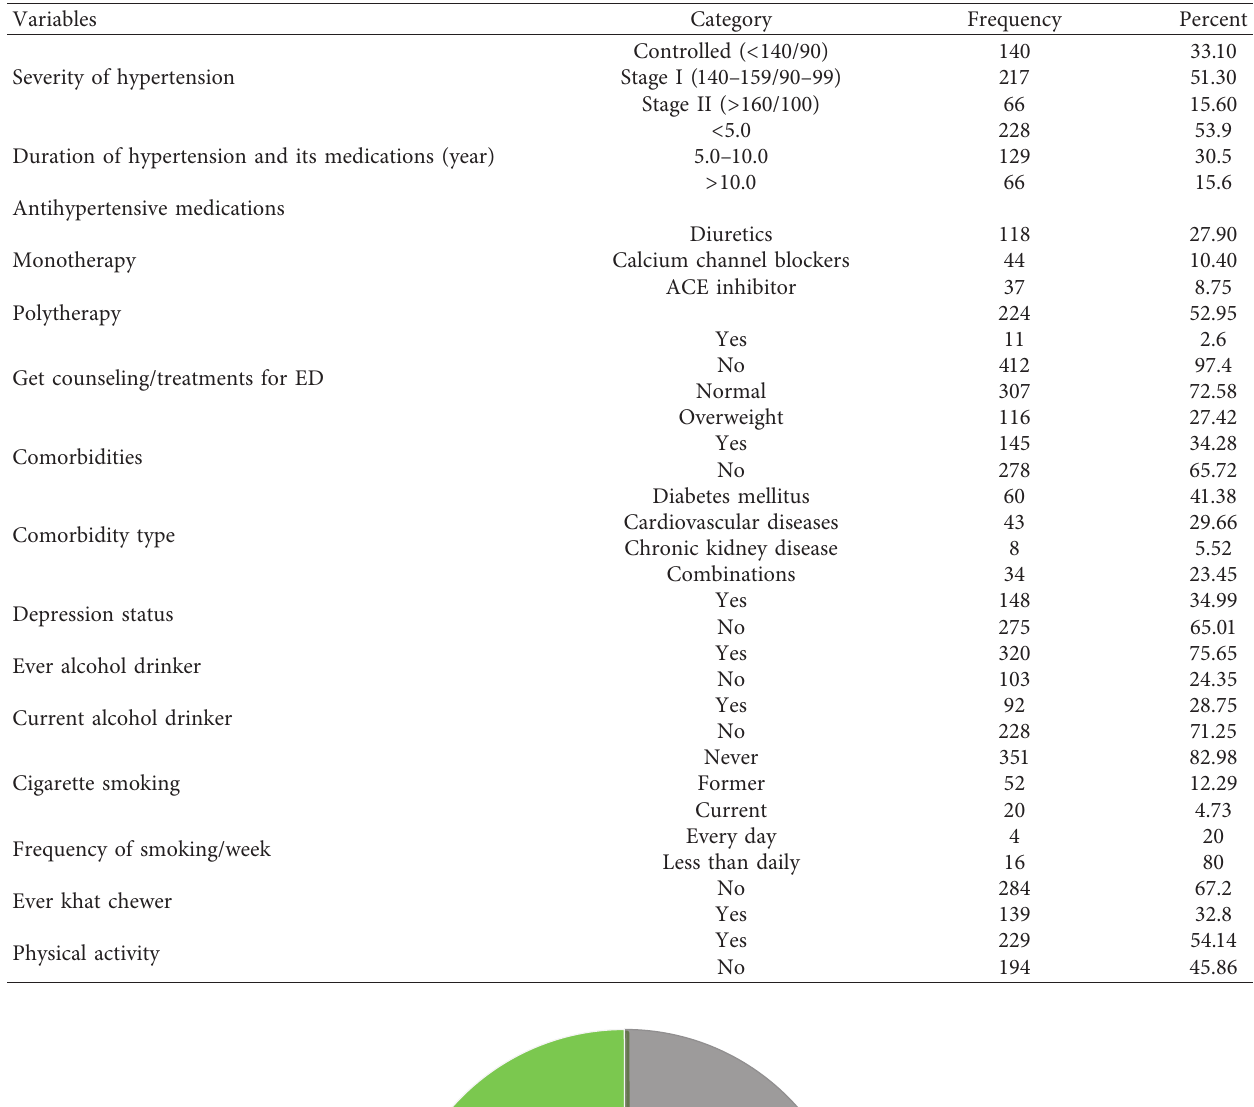
Table 2: Clinical, anthropometric, and behavioral characteristics of hypertensive patients attending governmental health institutions in Gondar city, Northwest Ethiopia, 2021 ( n � 423).